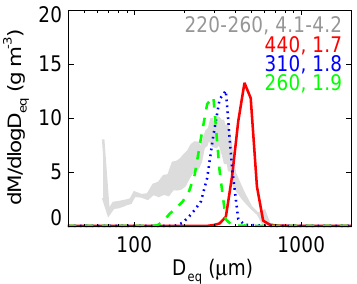
Figure 11. Particle size distributions of fluffy ice at − 40 ◦ C for simulations as in Fig. 10 with parcel depth (cid:49)z = 1km and pseudo- Hallett–Mossop sources of 1 (red solid line), 2 (blue dotted line), and 3stdcm − 3 (green dashed